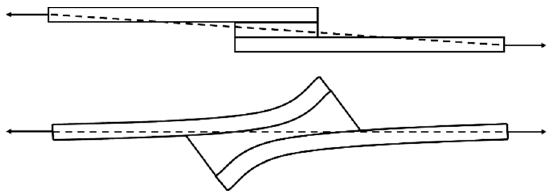
Figure 2. Representation of lap shear bending due to eccentricity in the load path.